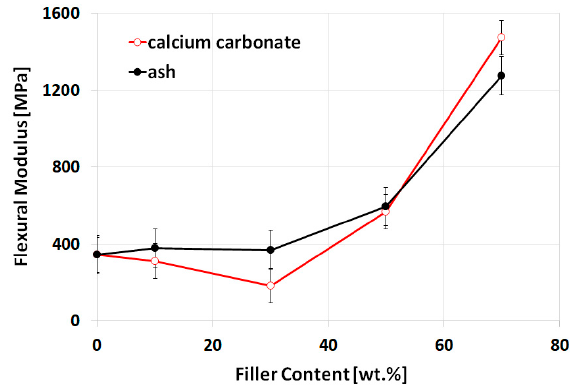
Figure 5. Flexural modulus as a function of filler content.